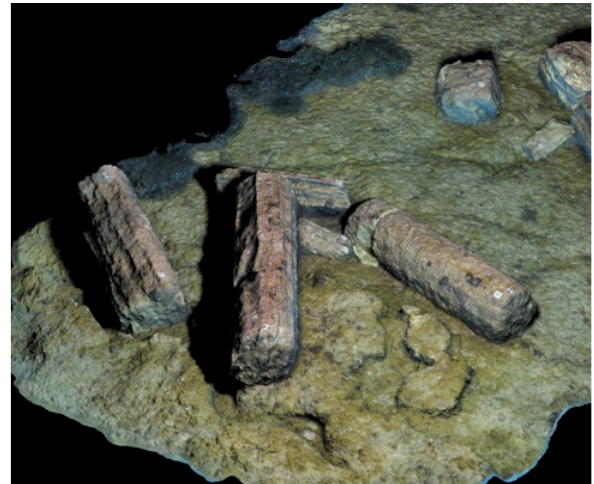
Figure 12. Mesh of the single blocks of Marzamemi shipwreck.